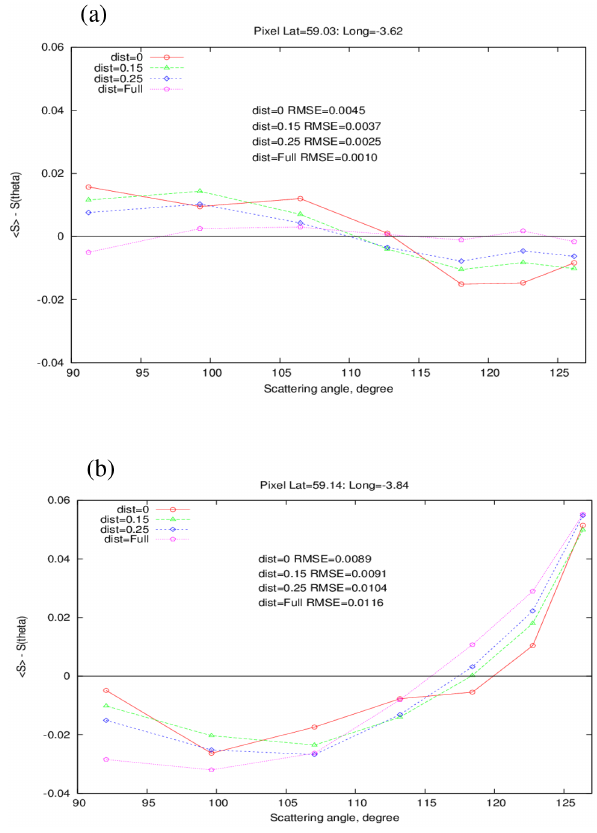
Figure 10. Differences between the directionally averaged (< S >) and directional ( S(θ) ) spherical albedos as a function of scattering angle at two pixel locations. (a) The spherical albedo differences for the pixel located at 59.03 ◦ and longitude − 3.62 ◦ , assuming the pristine ensemble model (dist = 0) (open red circles), the slightly distorted model (dist = 0.15) (open green triangles), the moderately distorted model (dist = 0.25) (open blue diamonds), and the fully randomised model (dist = 0.4 with spherical air bubble inclusions) (open purple pentagons). (b) The same as (a) but for the pixel lo- cated at latitude 59.14 ◦ and longitude − 3.84 ◦ . The zero difference line is shown by the solid bold line, and the RMSE values calculated for each of the models are shown in each of the